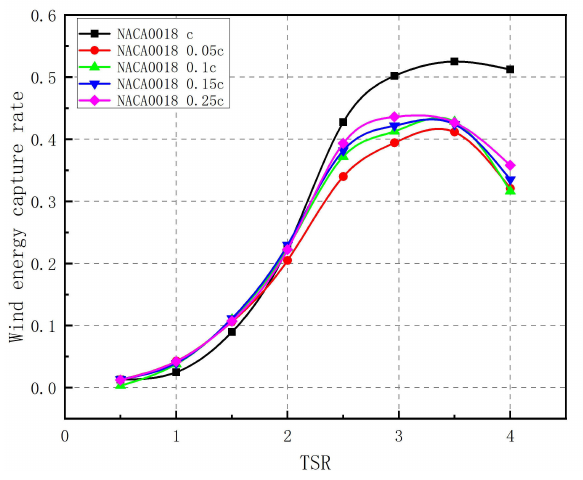
Figure 29. Wind energy capture rate of wind generator with two-dimensional